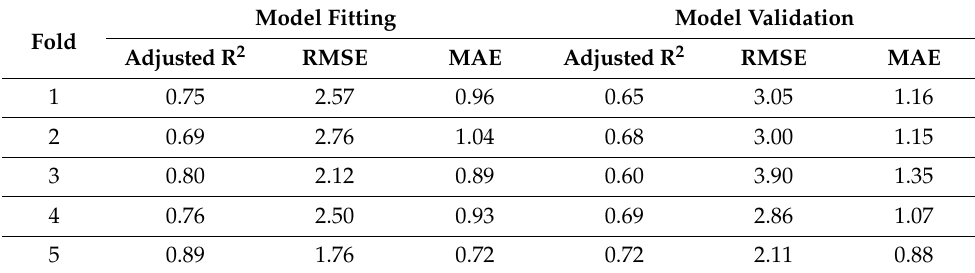
Table 4. Performance of the GTWR model in